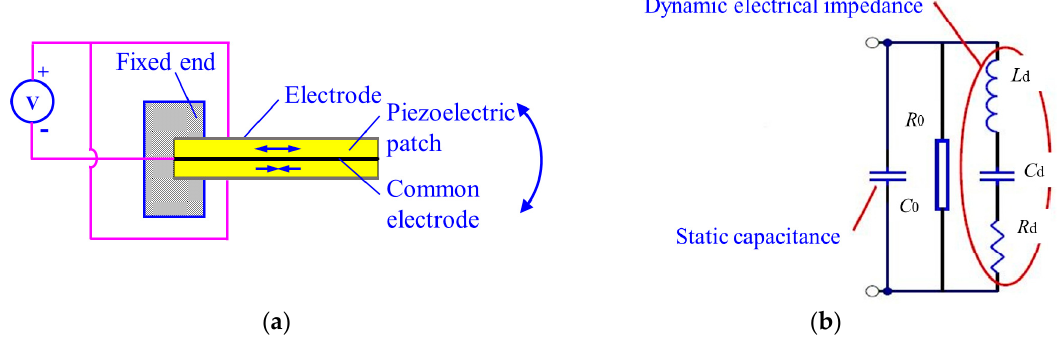
Figure 1. Piezoelectric bimorph beam ( a ) the structure; ( b ) equivalent circuit.